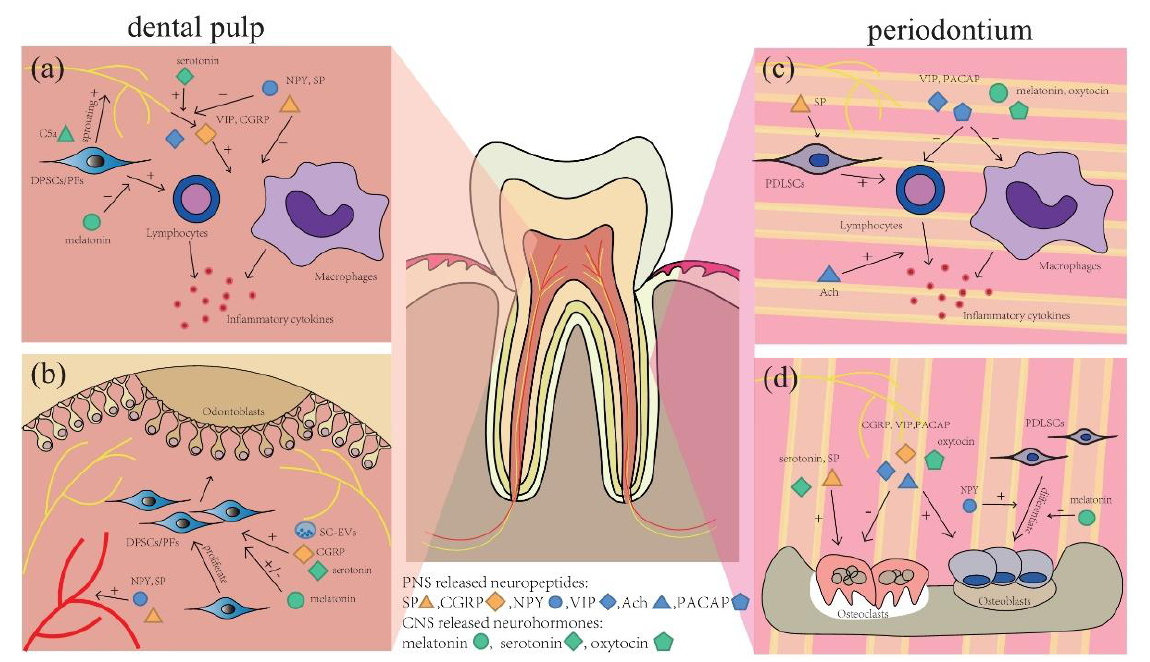
Figure 2. Neural regulation in tooth and periodontal diseases. During pulpitis, ( a ) C5a stimulates neurotrophins release from DPSCs/pulp fibroblasts (PFs) to induce nerve fiber sprouting. Melatonin, VIP, and CGRP are anti-inflammatory, while NPY and SP are proinflammatory. Serotonin enhances CGRP release, while NPY attenuates it. ( b ) Serotonin, melatonin, CGRP, and extracellular vesicles from Schwann cells (SC-EVs) can regulate the formation of restorative dentin by affecting DPSCs/PFs proliferation and differentiation. SP and NPY contribute to pulp hyperemia. In the periodontium, ( c ) PACAP, VIP, melatonin, and oxytocin are anti-inflammatory, while Ach and SP conduce to periodontal inflammation. ( d ) CGRP, PACAP, VIP, and oxytocin directly promote bone regeneration, and NPY promotes osteogenesis by PDLSCs. Meanwhile, SP, serotonin and melatonin induce periodontal destruction.